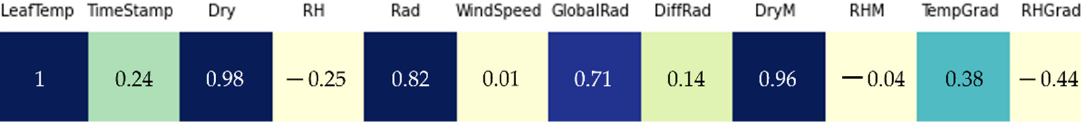
Figure 6. Correlation between leaf temperate and the different features. Darker color represents a higher correlation. Values indicate the correlation coefficients.